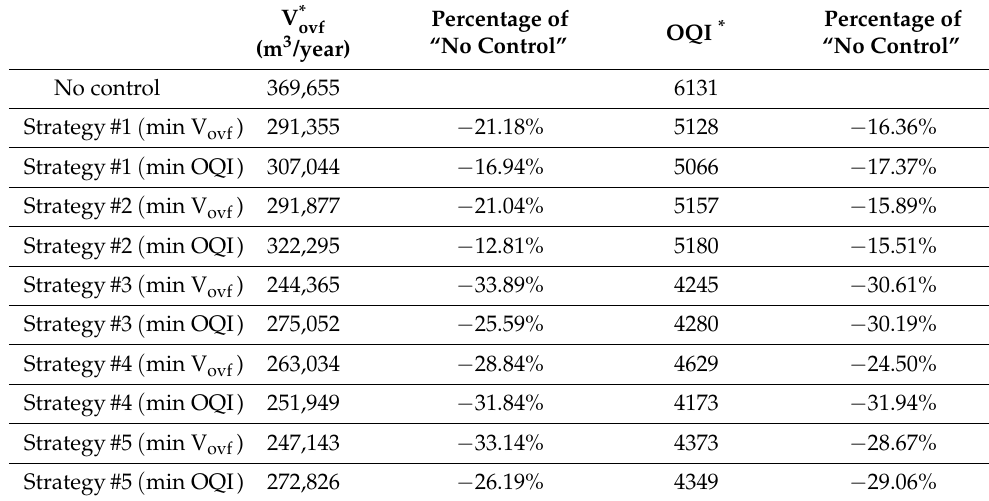
Table 17. Simulation results for solutions of the five strategies with both fitness functions.